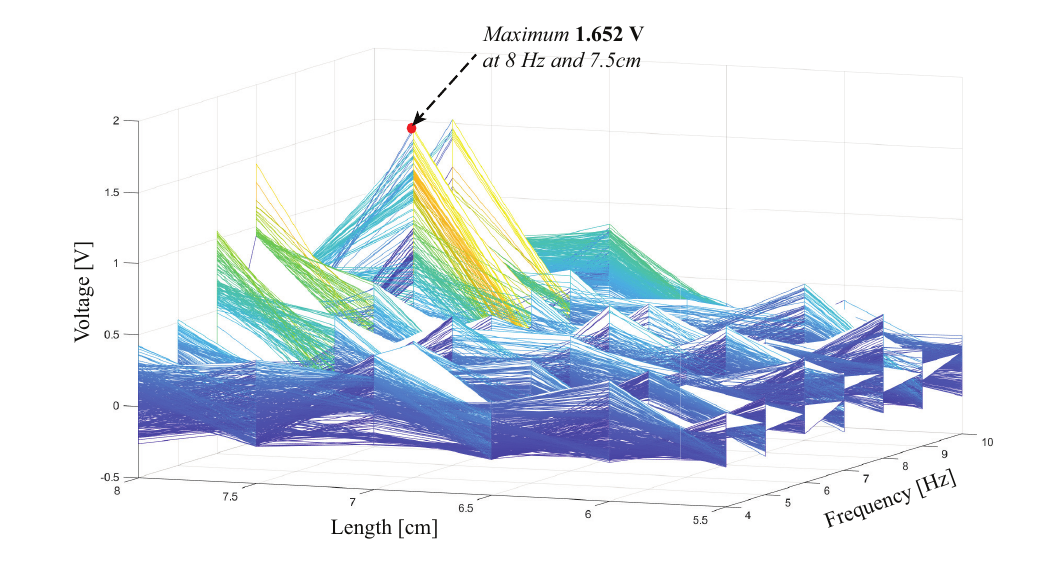
Figure 24. Energy harvesting for Replica 1. The maximum generated voltage was 1.625